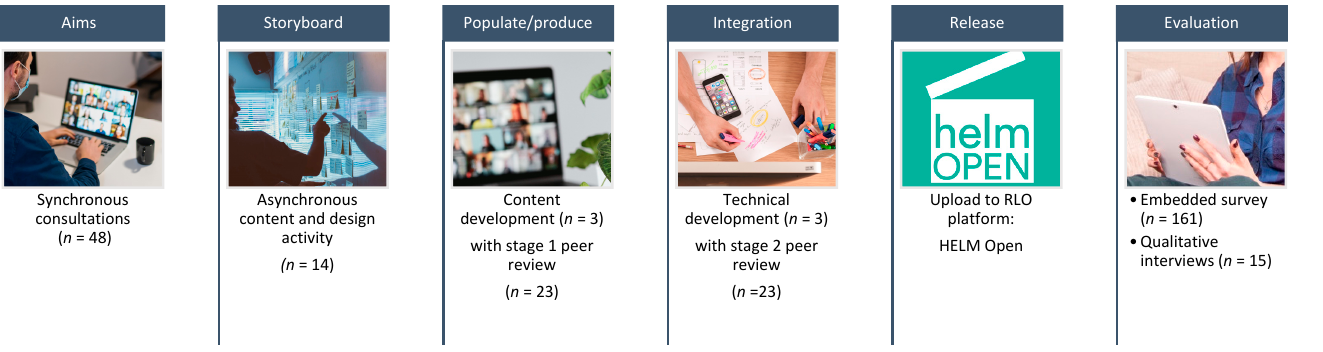
Figure 1. ASPIRE methodology for CoVE package development.